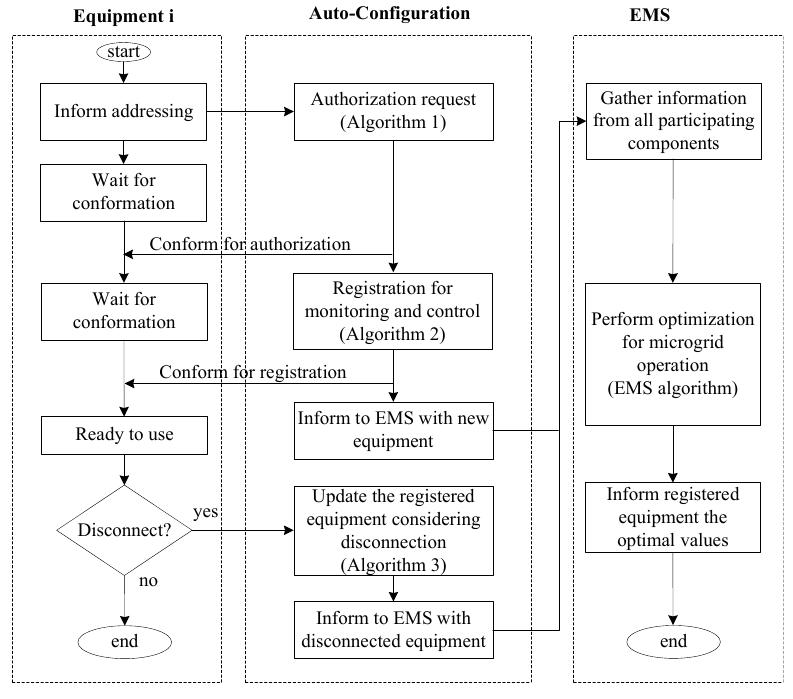
Figure 3. Main sub-functions of auto-configuration.